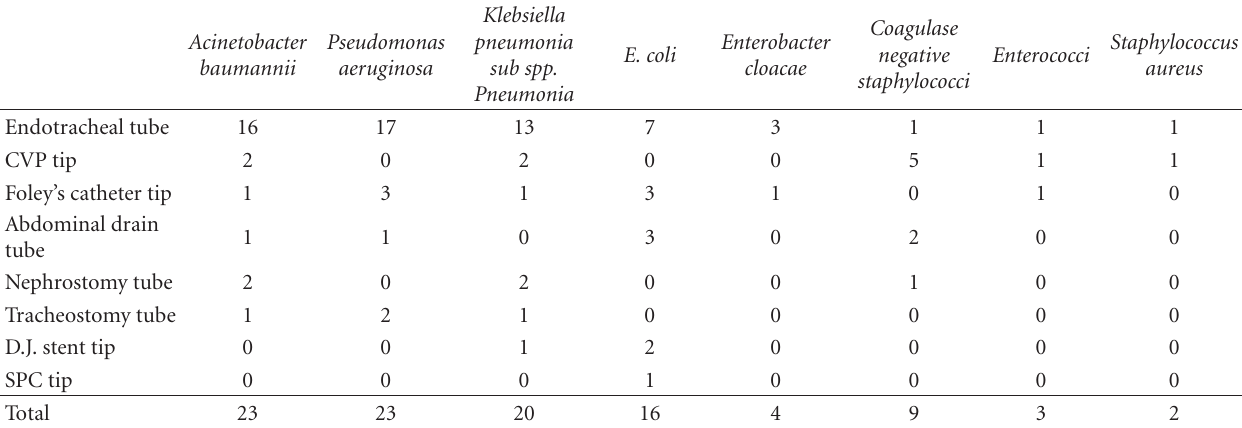
Table 1: Relation of clinical bacterial isolates and the type of device inserted.